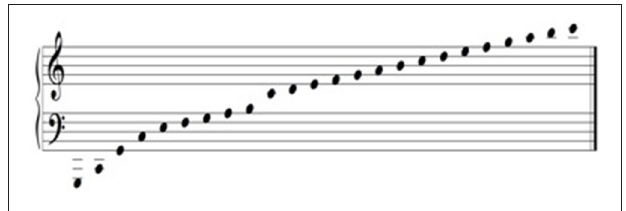
FIGURE 1 | Pitch Frequency array used in the sonification of individual northern elephant